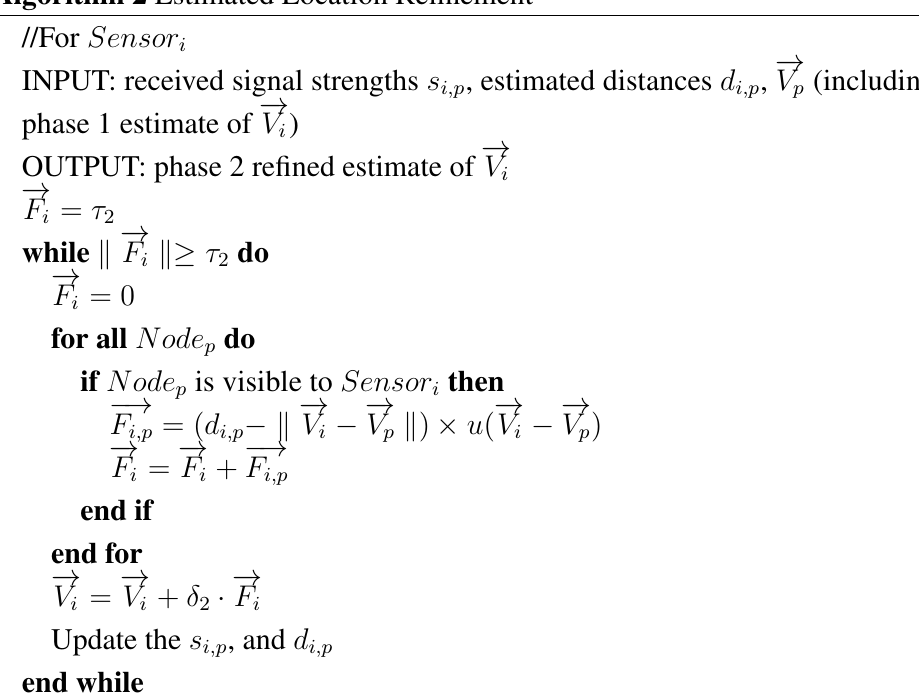
Algorithm 2 Estimated Location